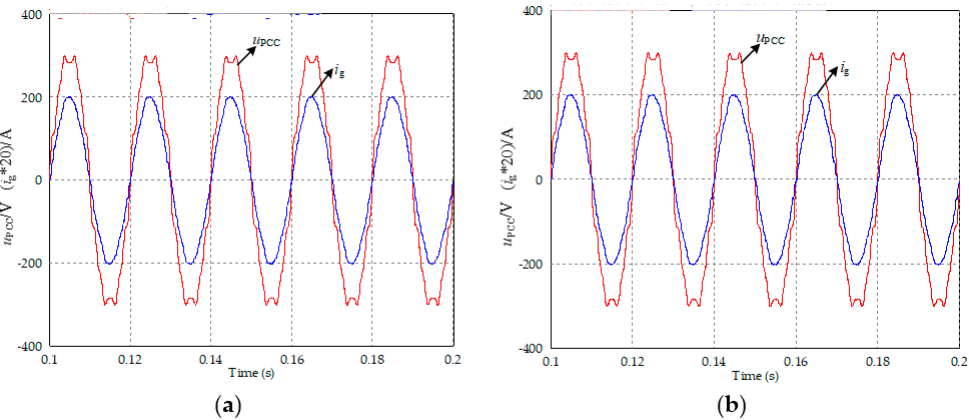
Figure 17. Simulation results of the proposed control strategy. ( a ) Waveforms of grid voltage and current. ( b ) FFT analysis of grid current (THD = current. ( b ) FFT analysis of grid current (THD = 2.8%).